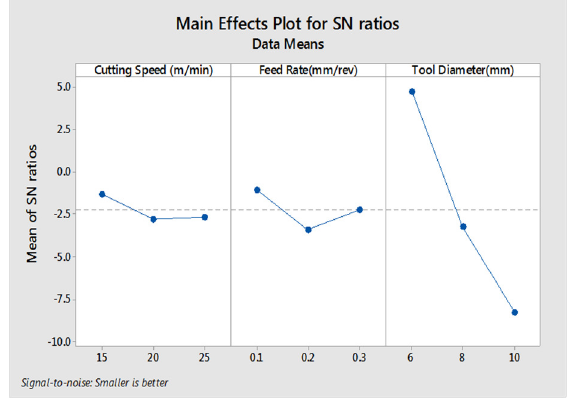
Fig. 6. The Effect Plots for Signal to Noise